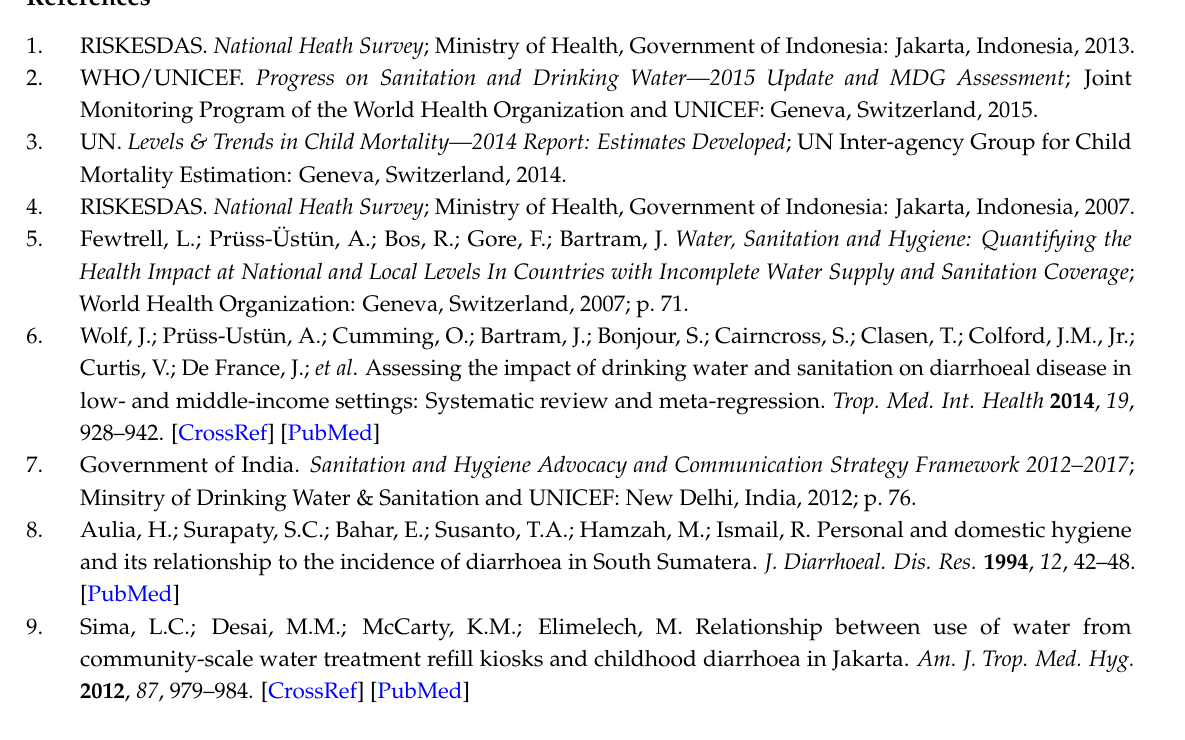
Table S1: Risk factors for diarrhea in children aged 0–23 months in Indonesia ( n = 4909)—Presentation of prevalence ratio (PR), Table S2: Subgroup analysis on association between diarrhea in children aged less than 24 months and disposal of child’s feces by biological indicators, socio economic indicators and wash indicators—Comparison of odds ratio (OR) and prevalence ratio